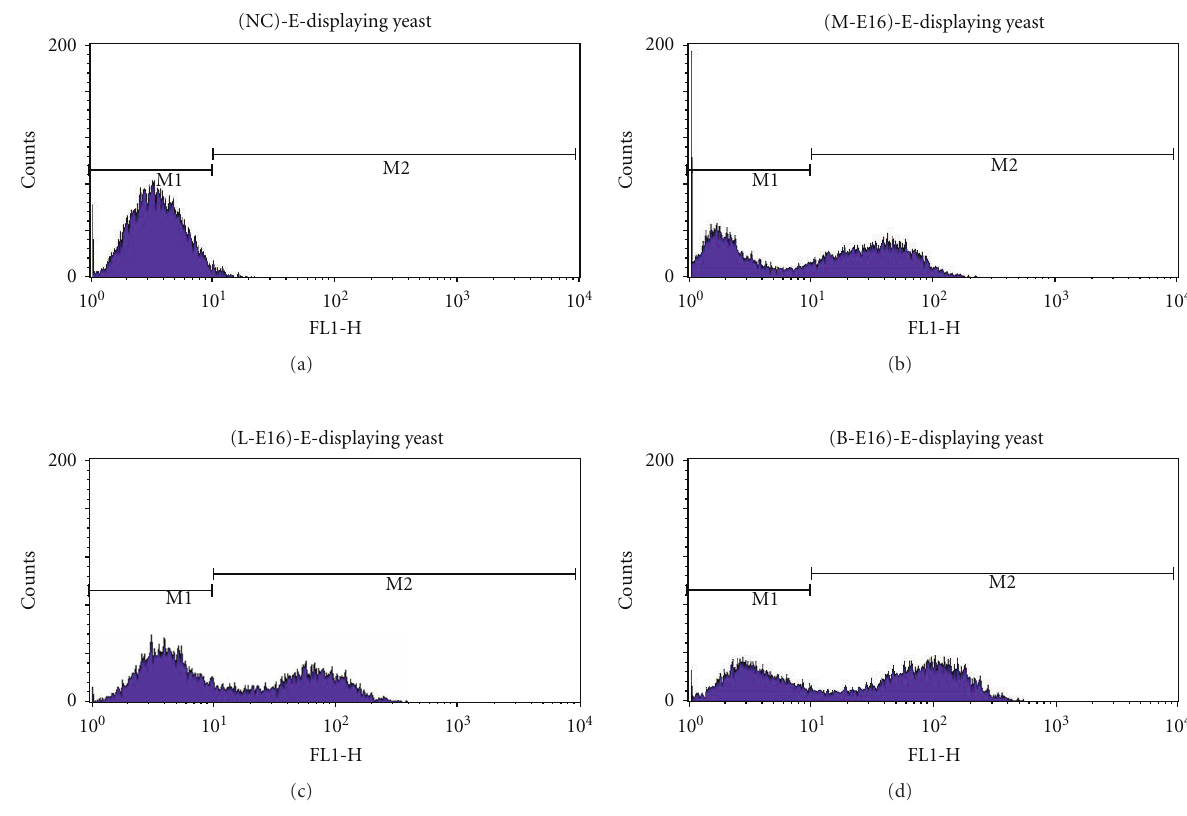
Figure 5: Identification of WNV E protein displayed on the cell surface of yeast by plant-derived E16 mAbs. Lettuce (L-E16) or N. benthamiana -produced E16 mAb (B-E16), mammalian cell-derived E16 (M-E16, positive control), or a generic human IgG (NC, negative control) was used to stain yeast cells displaying WNV E protein, which were then processed by flow cytometry. Representative data from three independent experiments are